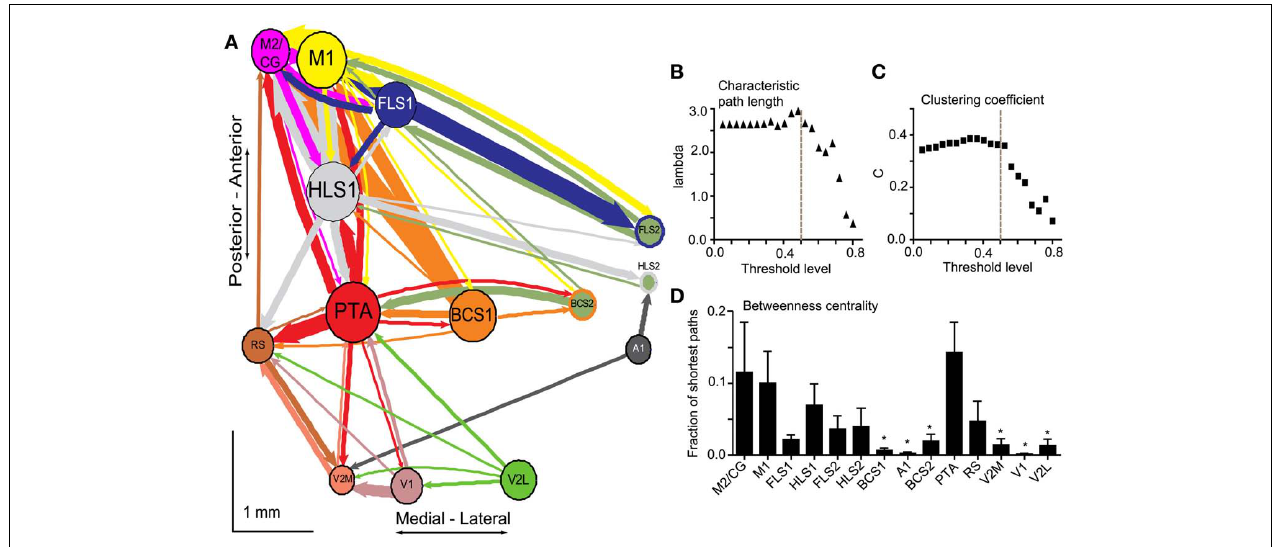
A threshold of 0.5 (dashed line) results in a 6% decrease in characteristic path length within the network. (C) Average clustering coefficient as a function of varying thresholds. A threshold of 0.5 (dashed line) results in a negligible change (0.13%) to clustering coefficient within the network. (D) Betweenness centrality calculated for each node (stimulation site; n = 6 mice) to determine the fraction of shortest paths that pass through a given node and define network hubs. Post-tests were calculated between PTA and all other nodes (* p <